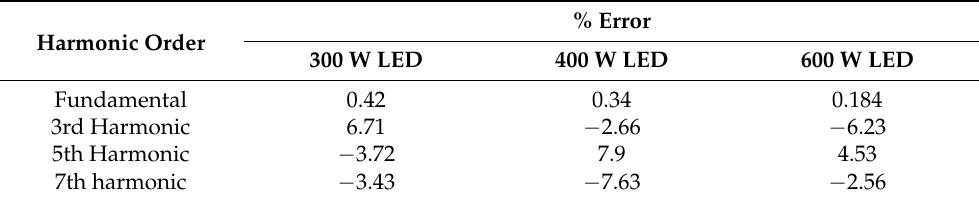
Table 1. Errors in Measurement in Fundamental and Harmonic Components for the 300 W, 400 W, and 600 W LED Luminaires.